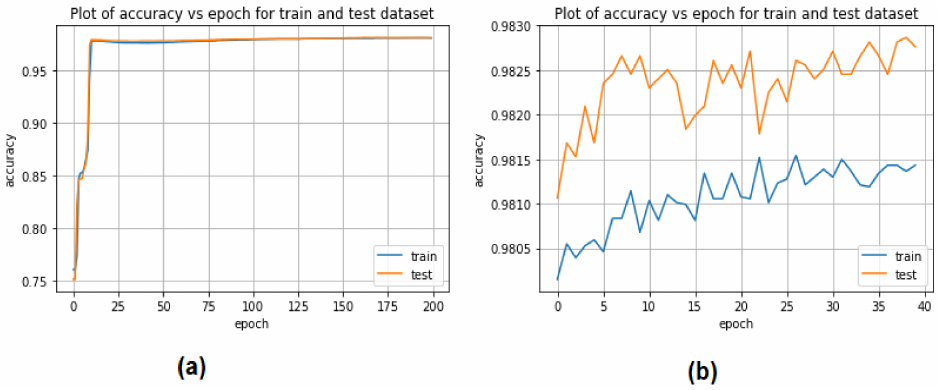
Figure 7. Performance of deep learning models for binary classification: ( a ) CNN, ( b ) LSTM. The CNN and LSTM training and testing models for detecting EDoS attacks using binary datasets are presented in Figure 8. The CNN model showed some accuracy in the training and testing phases, decreasing from 0.45 to 0.10 with 20 epochs. The accuracy of the LSTM approach with 20 epochs was low, ranging from 0.057 to 0.053 in the testing stage and from 0.058 to 0.052 in the training phase.